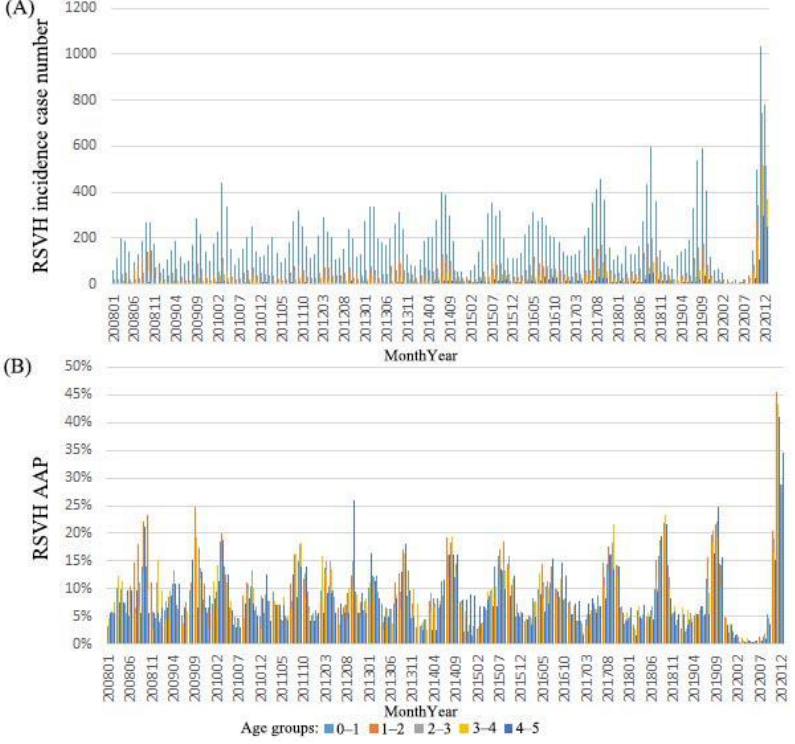
Figure 3. Monthly number ( A ) and AAP ( B ) of RSVHs among 0–5-year-old children. ( A )